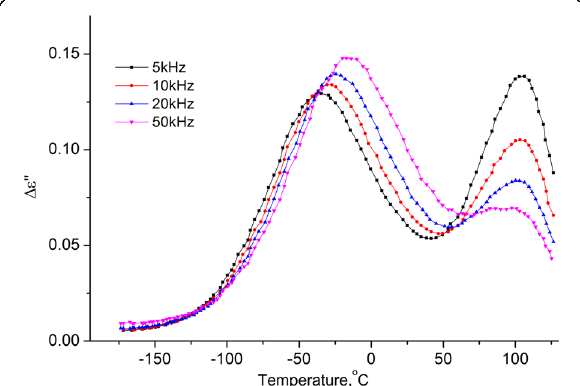
Fig. 11 Temperature dependence of imaginary part of the dielectric permittivity of MCC + 2.8% H 2 O. Temperature dependence of imaginary part of the dielectric permittivity of MCC + 2.8% H 2 O on frequencies 5, 10, 20, and 50 kHz